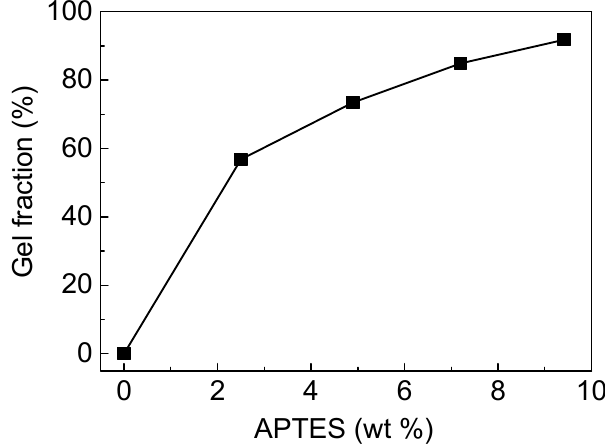
Figure 2. Gel fractions of polyurethane films prepared by DSPDs with different amounts of APTES. Films were dried at room temperature for 48 h and extracted with tetrahydrofuran for 48 h using a Soxhlet extractor.